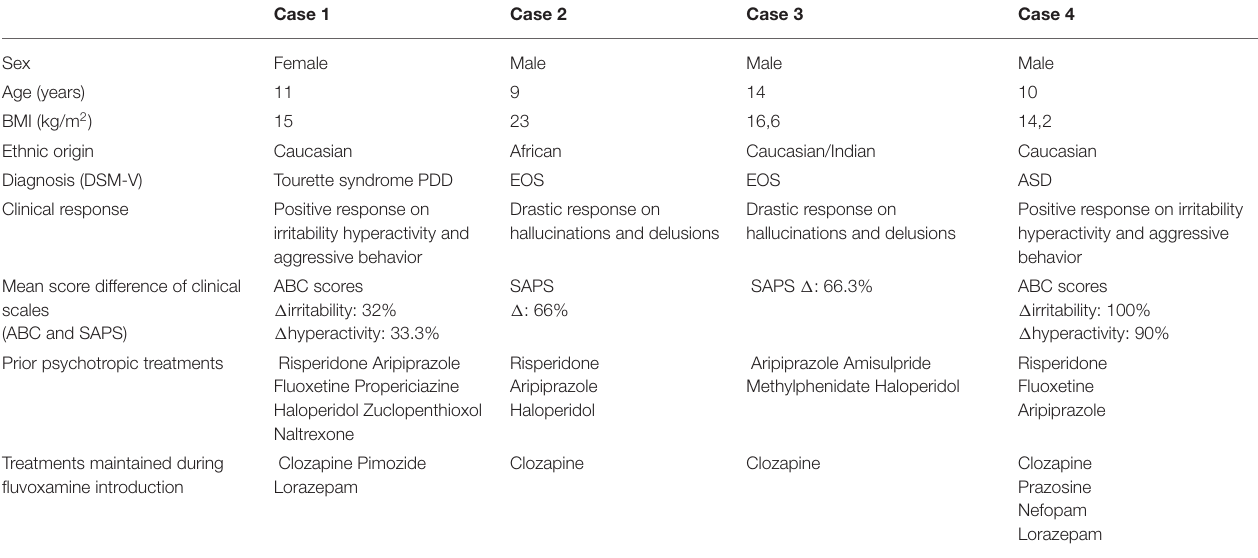
TABLE 2 | Demographics, diagnosis, clinical response, and treatments.